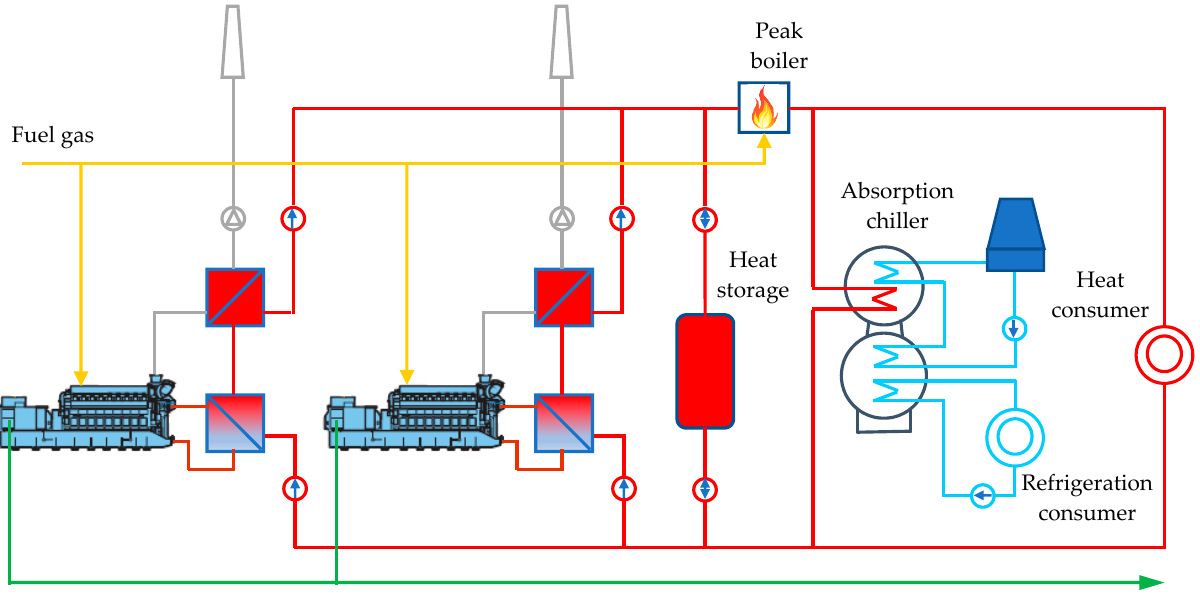
Figure 25. Trigeneration with two units, heat storage, and a peak boiler.